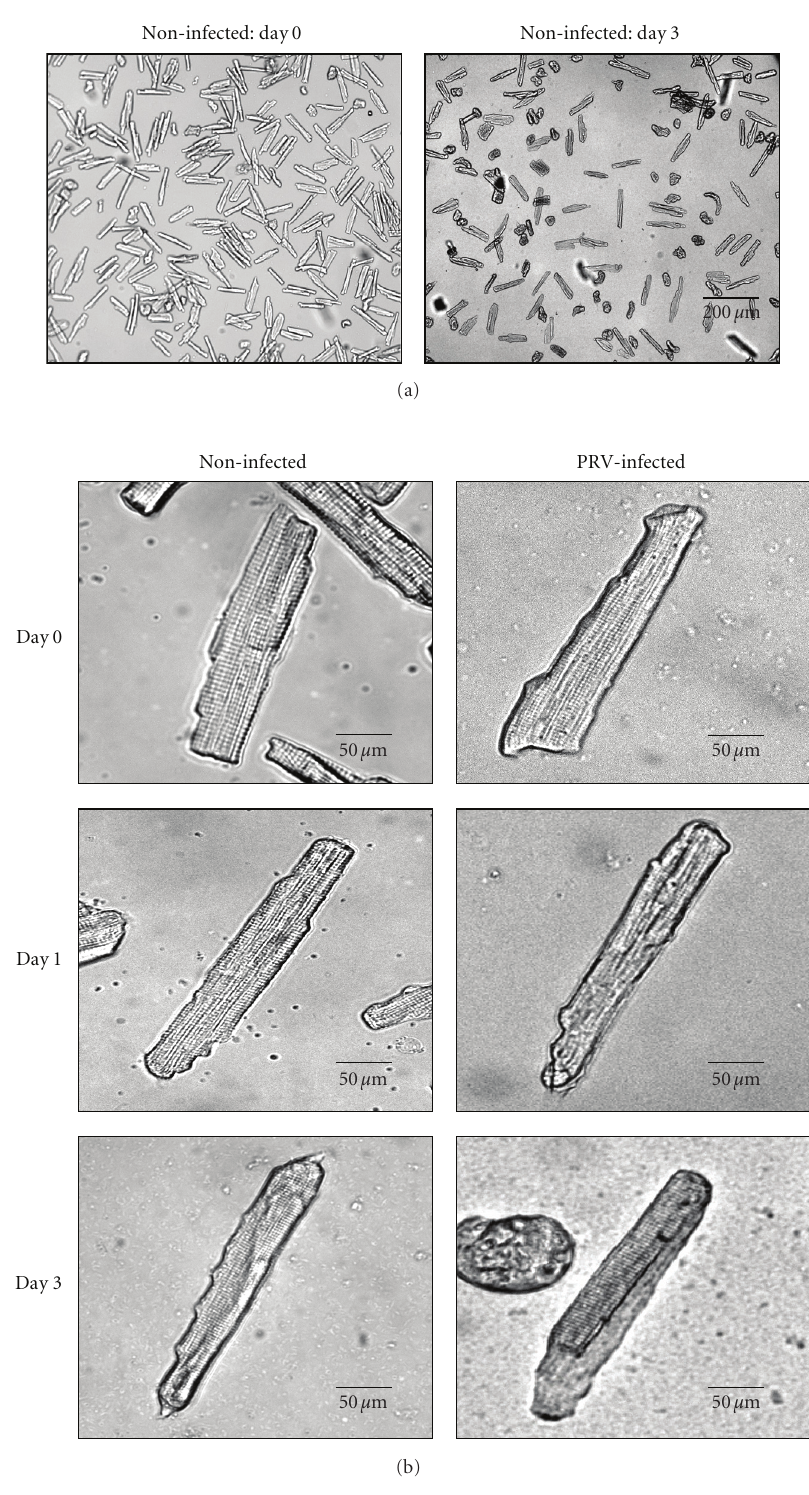
Figure 2: Representative low- and high-magnification transillumination of adult dog myocytes after isolation (day 0) and 1–3 days of culture (day 1, day 3). (a) shows the yield of the myocytes before and one day after culturing and infection. The high-magnification transillumination (b) shows the morphology of adult dog myocytes after isolation (day 0) and 1–3 day of culture (day 1, day 3) and the morphological changes of living cells, versus the culturing time from noninfected (right) and the virus-infected groups (left). After one day plated myocytes more than 80% displayed a rod-shaped morphology and healthy cross-striation. After 3 days (day 3) in culture, cells remained rod-shaped and partially cross-striated, and the main change was that cell ends became progressively more